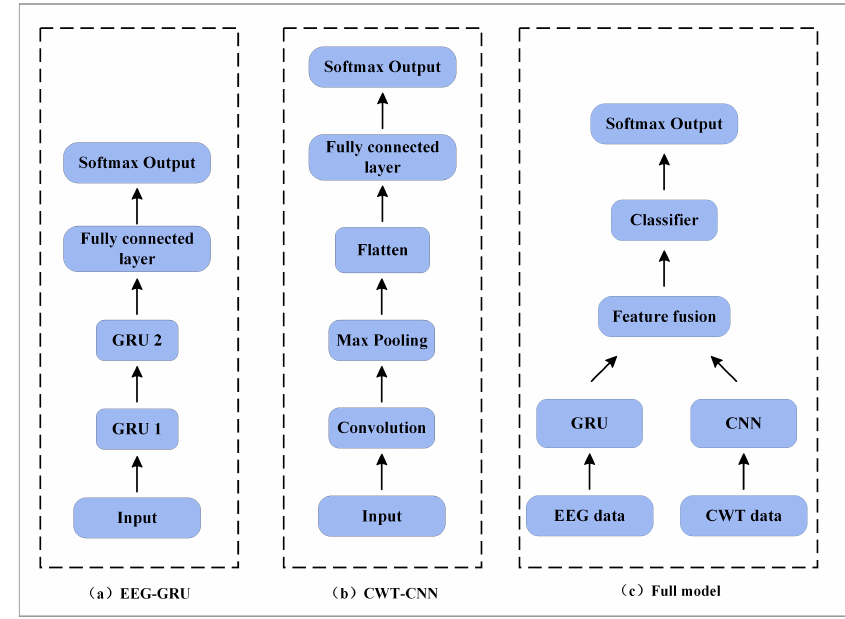
Figure 7. Network model of the ablation experiments.